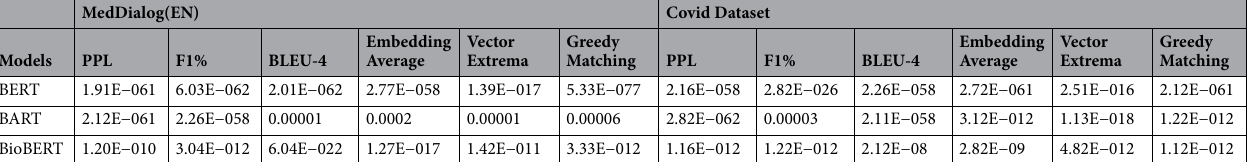
Table 8. Results of statistical significance test for automatic evaluation metrics.